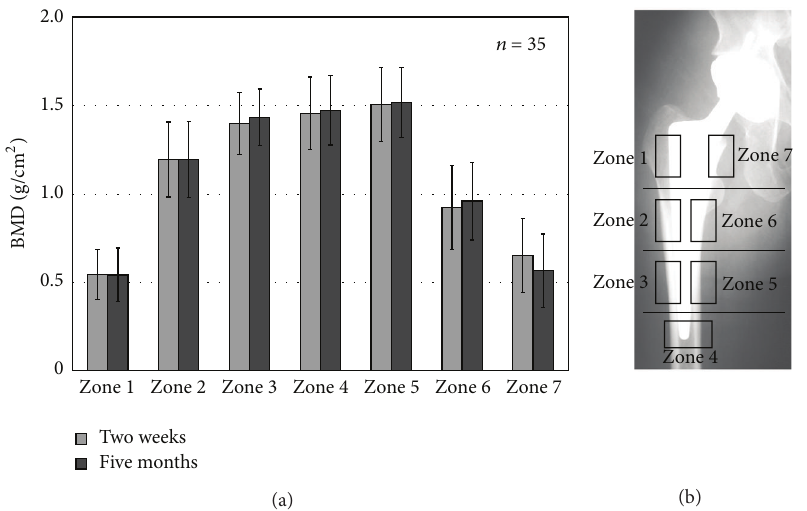
Figure 3: BMD measured by DEXA. (a) BMD values in each zone 2 weeks and 5 months after the operation. (b) X-ray image and Gruen’s zone classification.